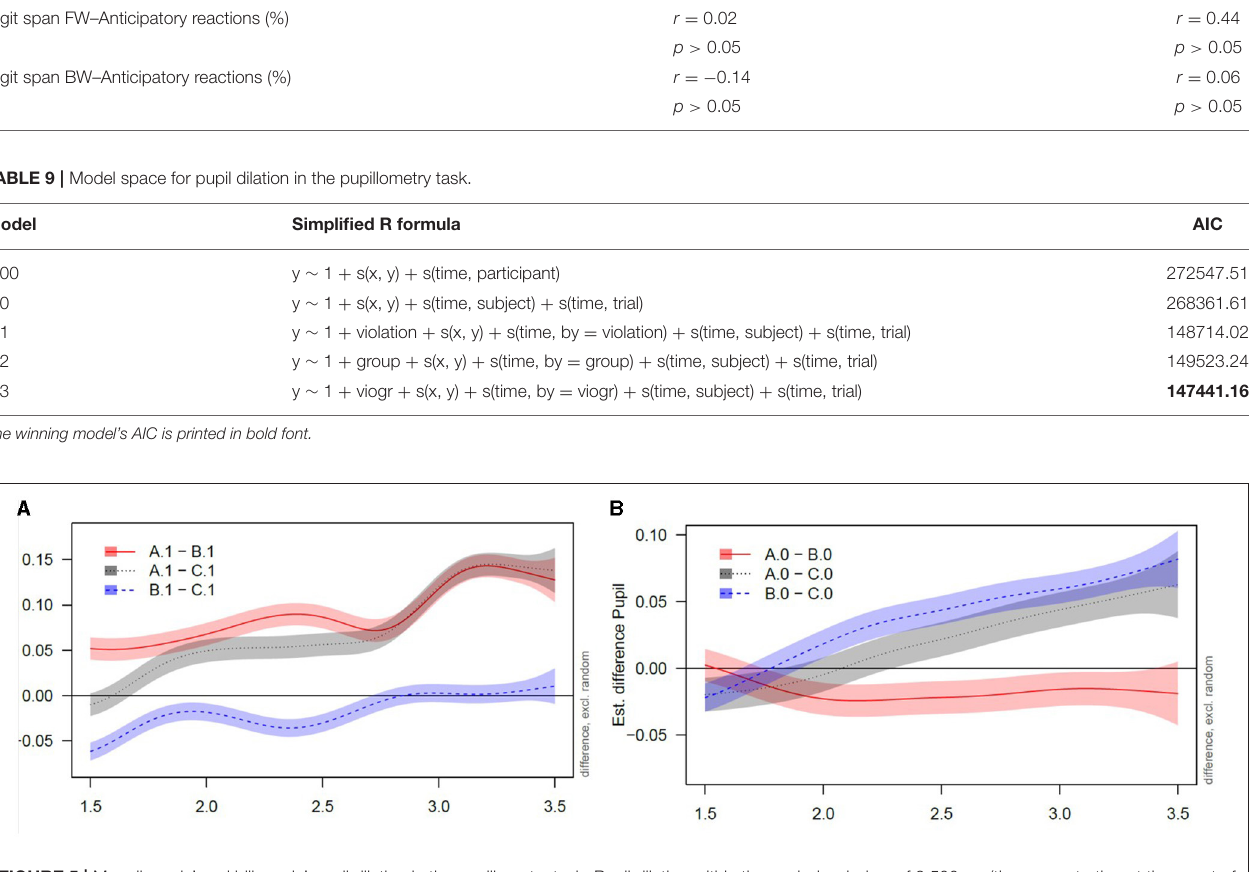
FIGURE 5 | Monolinguals’ and bilinguals’ pupil dilation in the pupillometry task. Pupil dilation within the analysis window of 3,500ms (time zero starting at the onset of the first object) with plotted differences between conditions. Curves around 0.00 indicate no difference between the plotted conditions (e.g., between A0 and B0). Curves deviating from 0.00 indicate differences between the plotted conditions in the pupil dilation trajectory. A1 = condition A (grammatical) in monolingual data; A0 = condition A (grammatical) in bilingual data; B1 = condition B (slightly ungrammatical) in monolingual data; B0 = condition B (slightly ungrammatical) in bilingual data; C1 = condition C (strongly ungrammatical) in monolingual data; C0 = condition C (strongly ungrammatical) in bilingual data. Panel (A) : Monolinguals. Panel (B) :